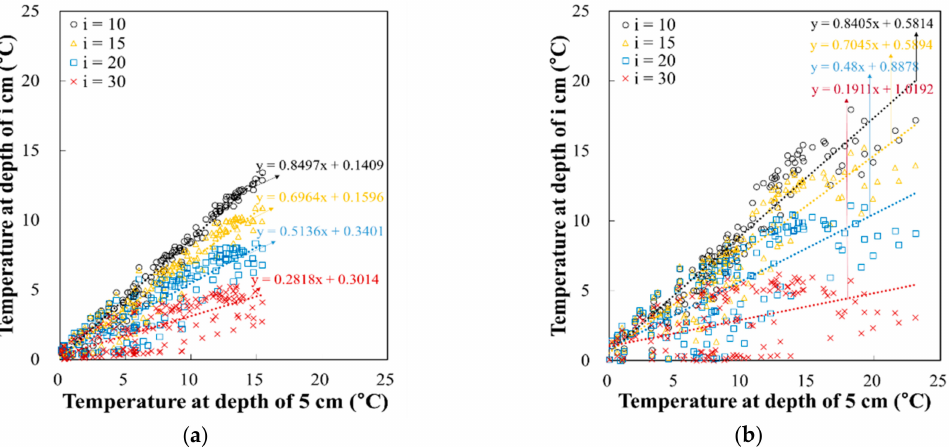
Figure 5. Relationships between soil temperature at a depth of 5 cm and those observed at depths of 10, 15, 20, and 30 cm in the ( a ) site A and ( b ) site